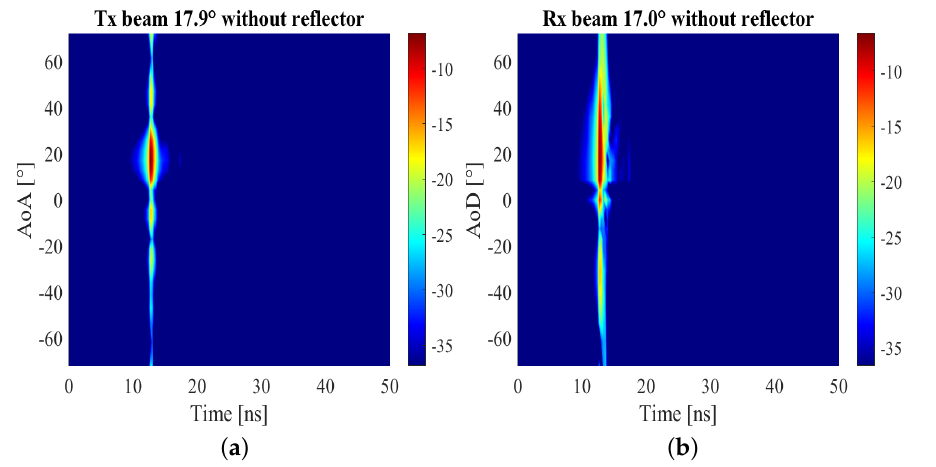
Figure 15. PADP of channel with ( a ) Tx beam-steering at 17.9° and ( b ) Rx beam-steering at 17.0°.